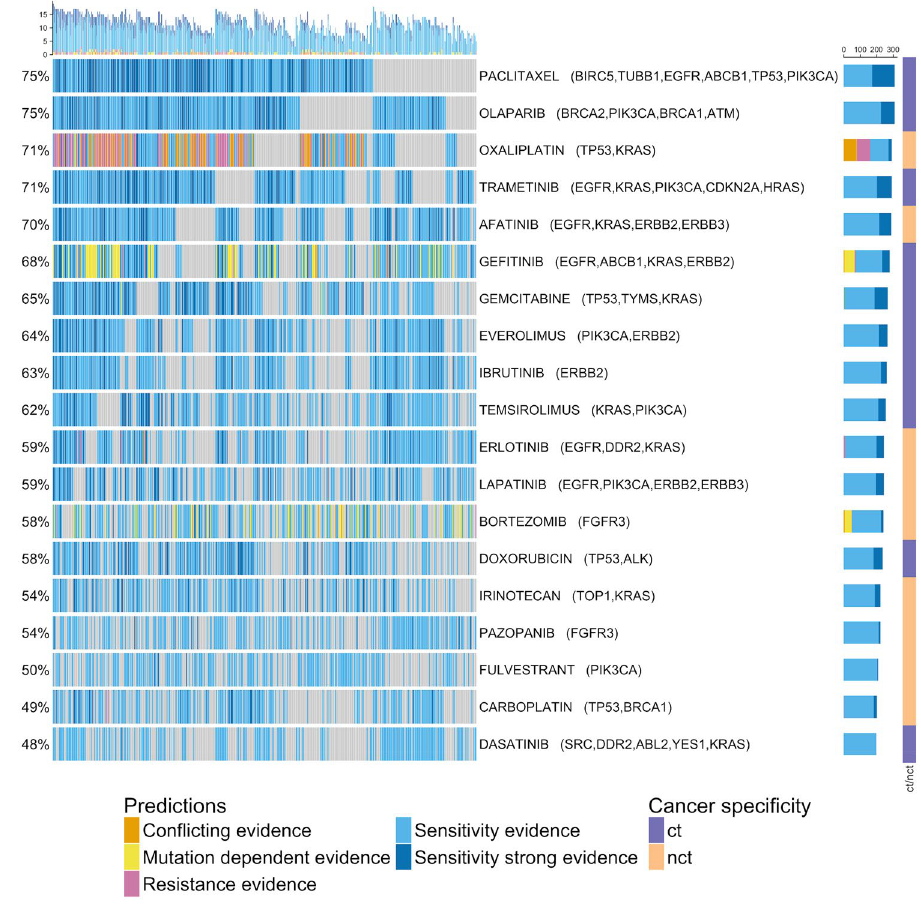
Figure 5. Oncoprint shows weighted evidence across samples based on drug response score (DRS) and curation support. Interacting genes are listed behind each drug. The direction/evidence categories are composed as following: Conflicting evidence: resistance prediction + DRS positive; Mutation dependent evidence: gene- dependent prediction + DRS positive/gene-dependent prediction + no DRS; Resistance evidence: resistance prediction + no DRS; Sensitivity evidence: sensitivity unspecific prediction + no DRS/sensitivity prediction + no DRS/no genomic + DRS positive; Sensitivity strong evidence: sensitivity unspecific prediction + DRS positive/ sensitivity prediction + DRS positive. “ct” and “nct” refer to cancer-type specific and non-cancer-type specific as defined above. (R Core Team (2019). R: A language and environment for statistical computing. R Foundation for Statistical Computing, Vienna, Austria. https ://www.R-proje ct.org/) 57